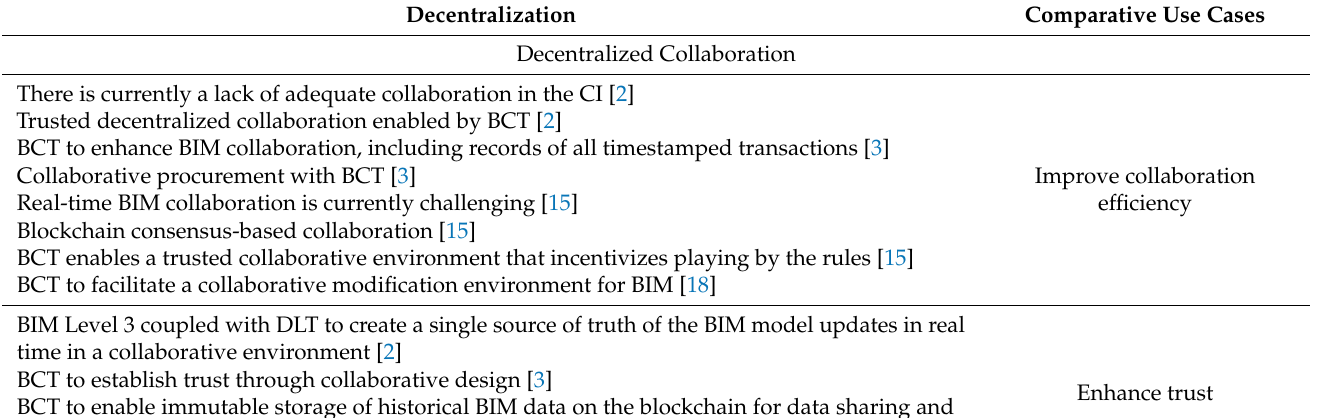
Table 2. Key factors affecting the BCDTs paradigm shift